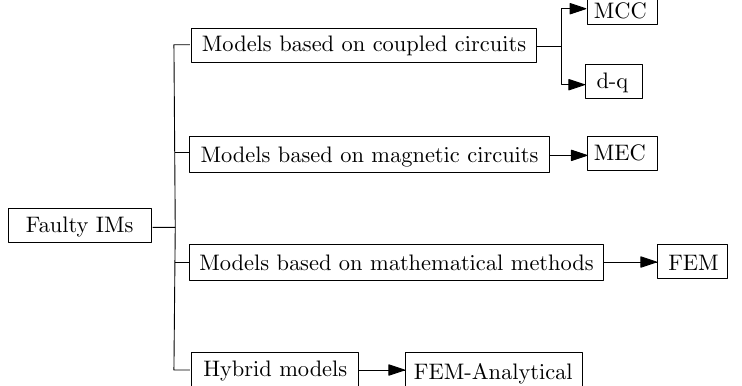
Figure 3. Breakdown of induction motor fault